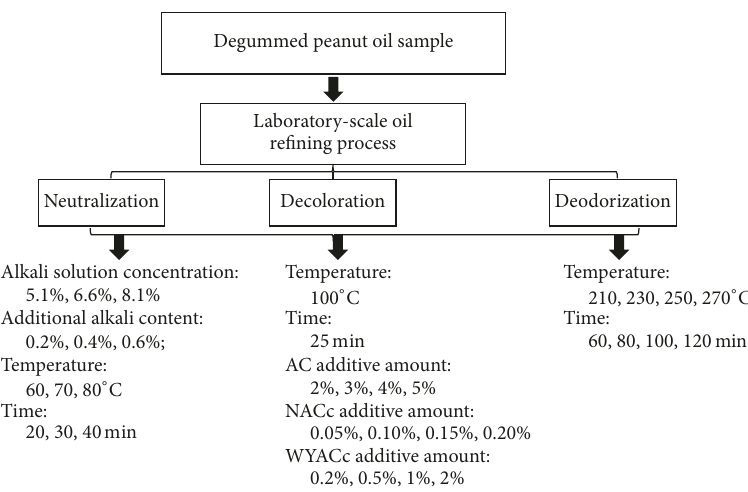
Figure 1: Flowchart for experimental design and all